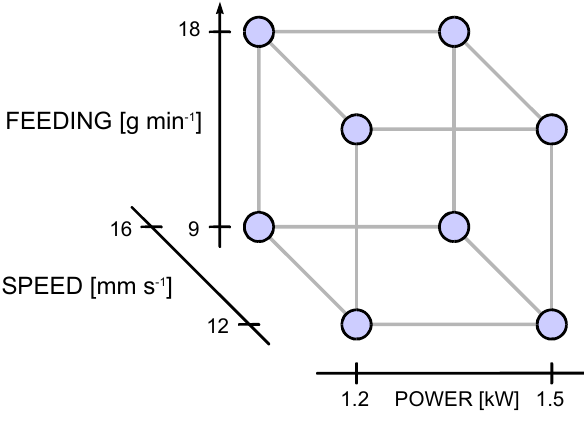
Figure 3. Testing scheme, full-factorial, 3-factor, 2-level plan. Table 3. Processing condition of the experimental plan for deposition over flat surface and edges.